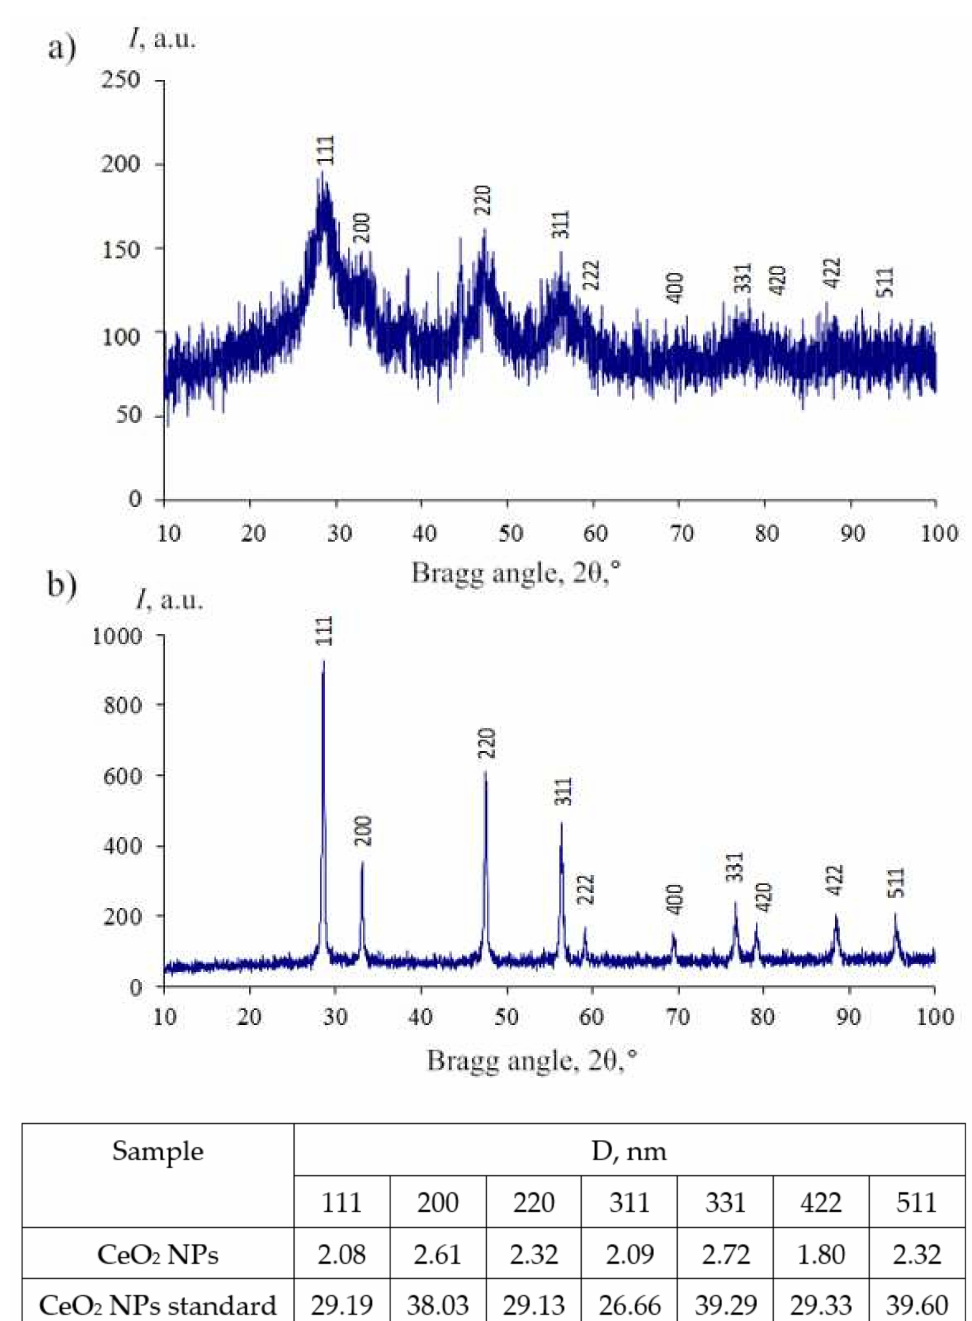
Figure 4. Powder XRD patterns of the cerium oxide nanoparticles modified by maltodextrin ( a ) and a standard sample of cerium oxide nanoparticles ( b